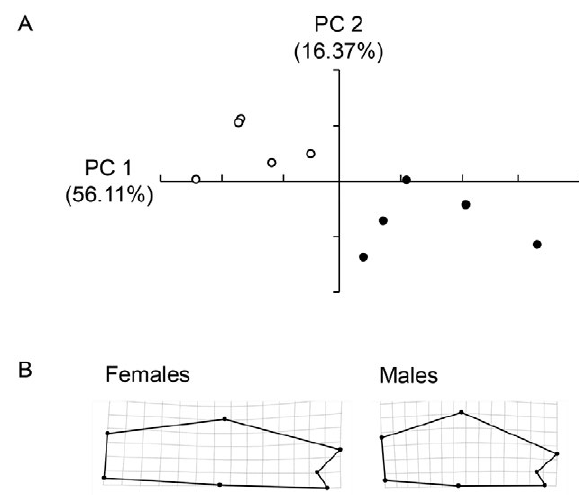
Fig. 4. – A, shape variation analysis for Pasiphaea sivado adults: females (white circles); males (black circles). The contribution percentages of the two principal components are presented on each axis. B, thin plate consensus shapes for each gender.